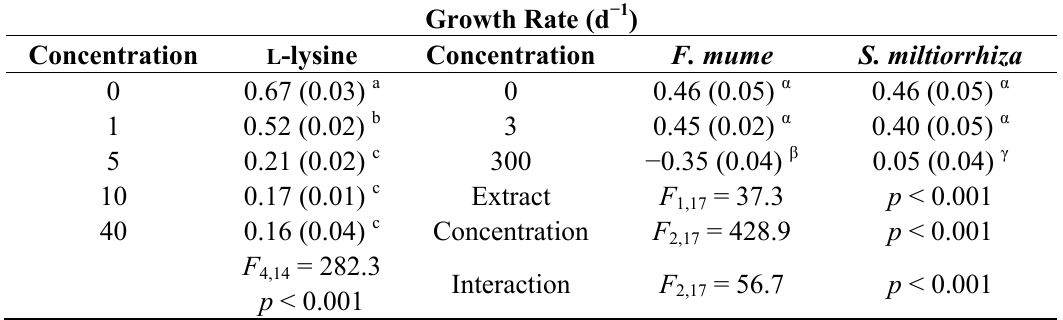
Table 2. Growth rates (d − 1 ) of Microcystis aeruginosa NIVA-CYA 43 grown for